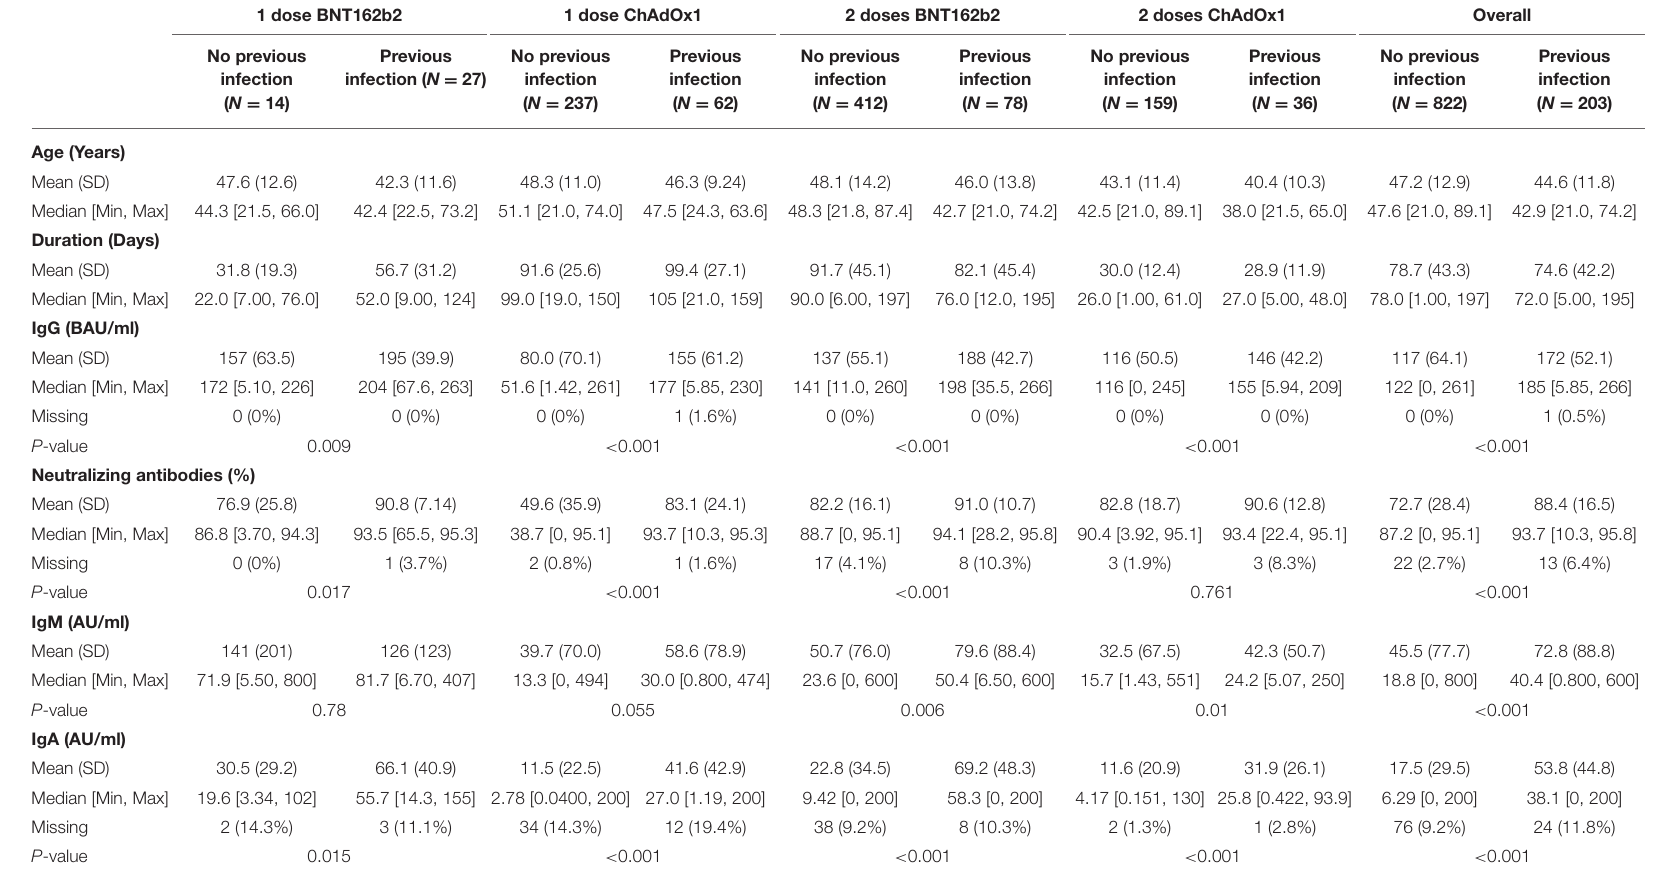
TABLE 2 | Cohort characteristics and serological results. 1 dose